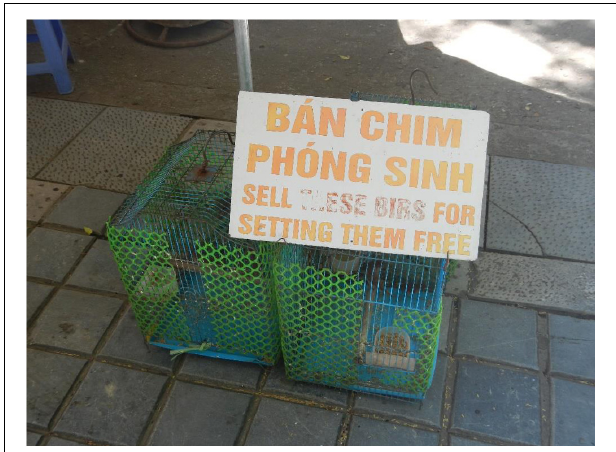
FIGURE 2 | Birds for sale at Huong Pagoda, Ha Noi, Vietnam (Magellan photo).